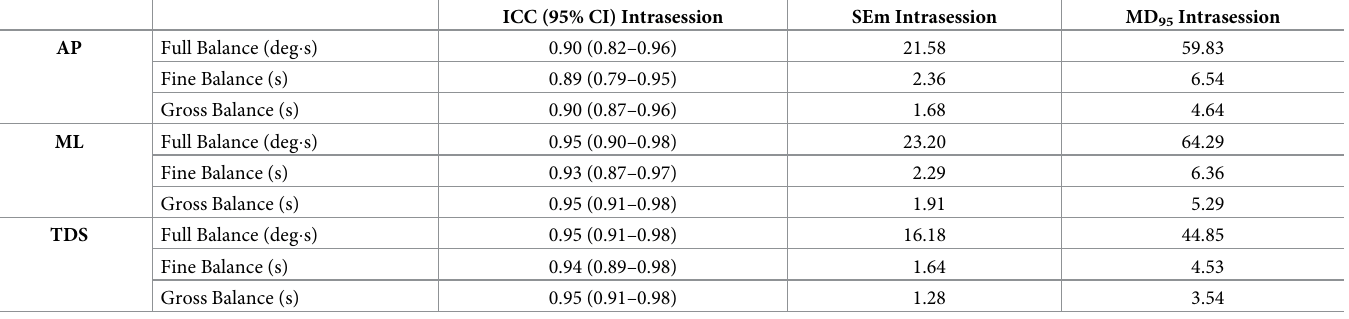
Table 6. Average intrasession [3, 10] intraclass correlation coefficient (ICC) and 95% Confidence Intervals (95% CI), Standard Error of the measurement (SEm), and Minimal Detectable Change (MD 95 ) calculated during the performances on the unstable board.